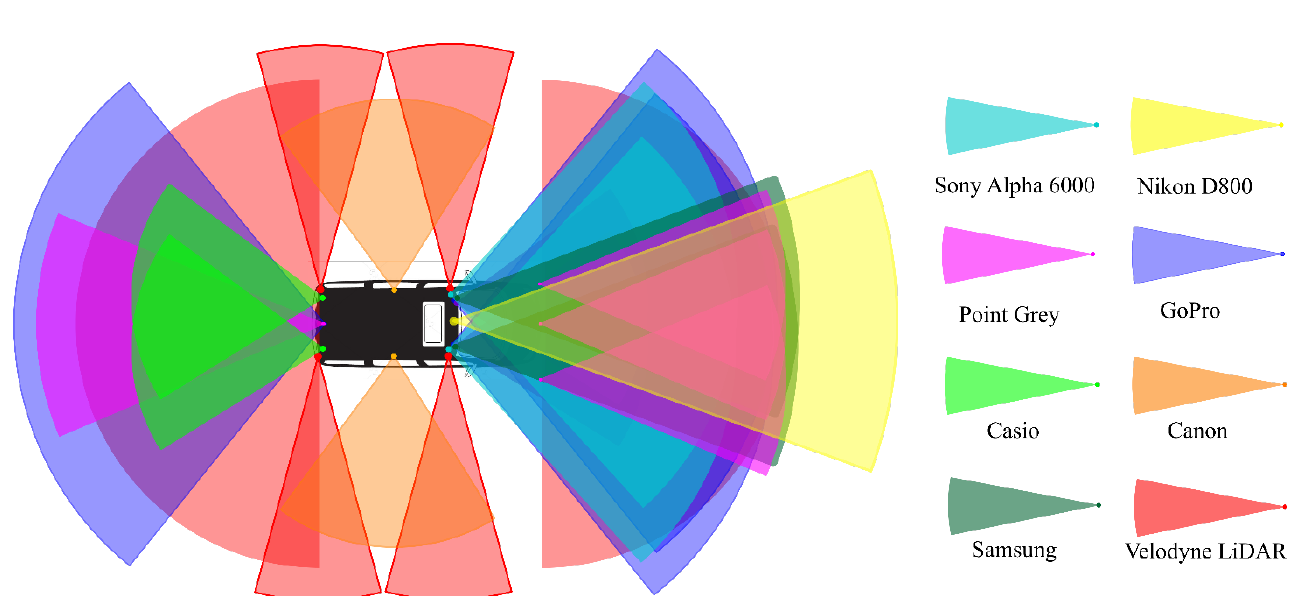
Figure 2. Field of views of the imaging sensors around the